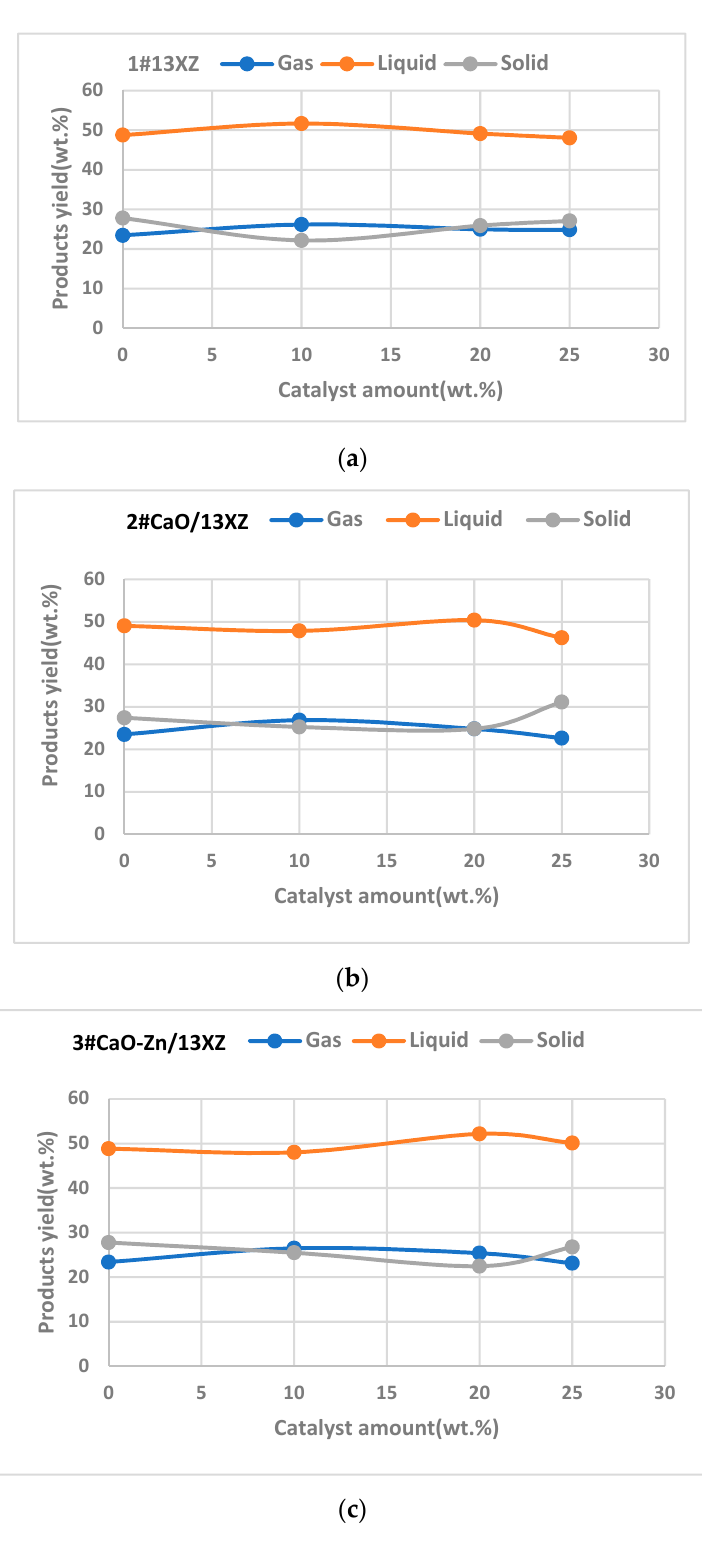
Figure 11. The influence of nanocomposites used as catalyst on product yields;( a )-using 1# 13XZ catalyst; ( b )-using 2# CaO/13XZ catalyst; ( c )-using 3# CaO-Zn/13XZ catalyst. A biomass/catalyst (B/C) ratio of 5:1 (respectively, the introduction of a quantity of 20% catalyst) produced a bio-oil yield of 49.14 ± 1.12, 50.37 ± 1.15 and 52.16± 1.20 wt.% for 1# 13XZ, 2# CaO/13XZ and 3# CaO-Zn/13XZ, respectively, compared to an average